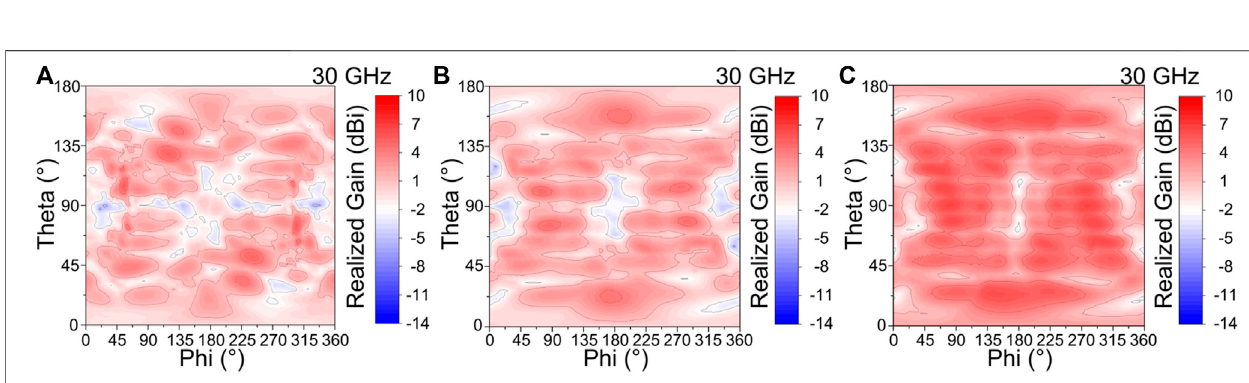
FIGURE 11 | Simulated total scan patterns (30 GHz) of the designed array antennas in the handset mockup (A) CPW TL (B) GCPW TL without via fences (C) GCPW TL with via fences.